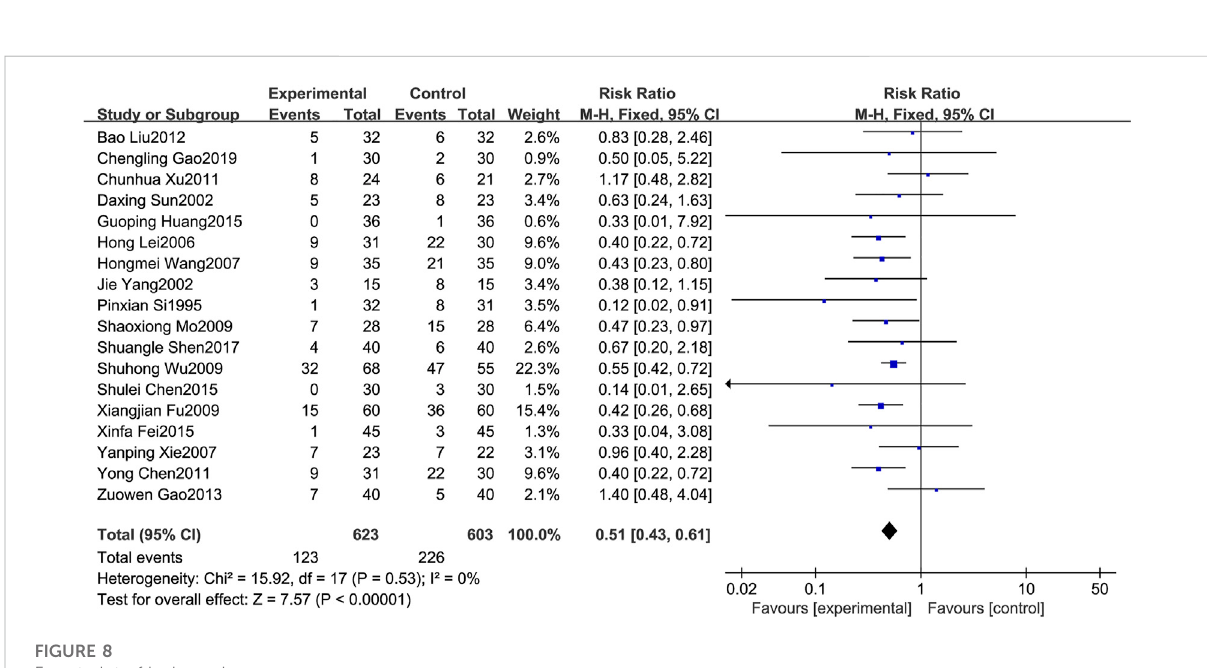
FIGURE 8 Forest plot of